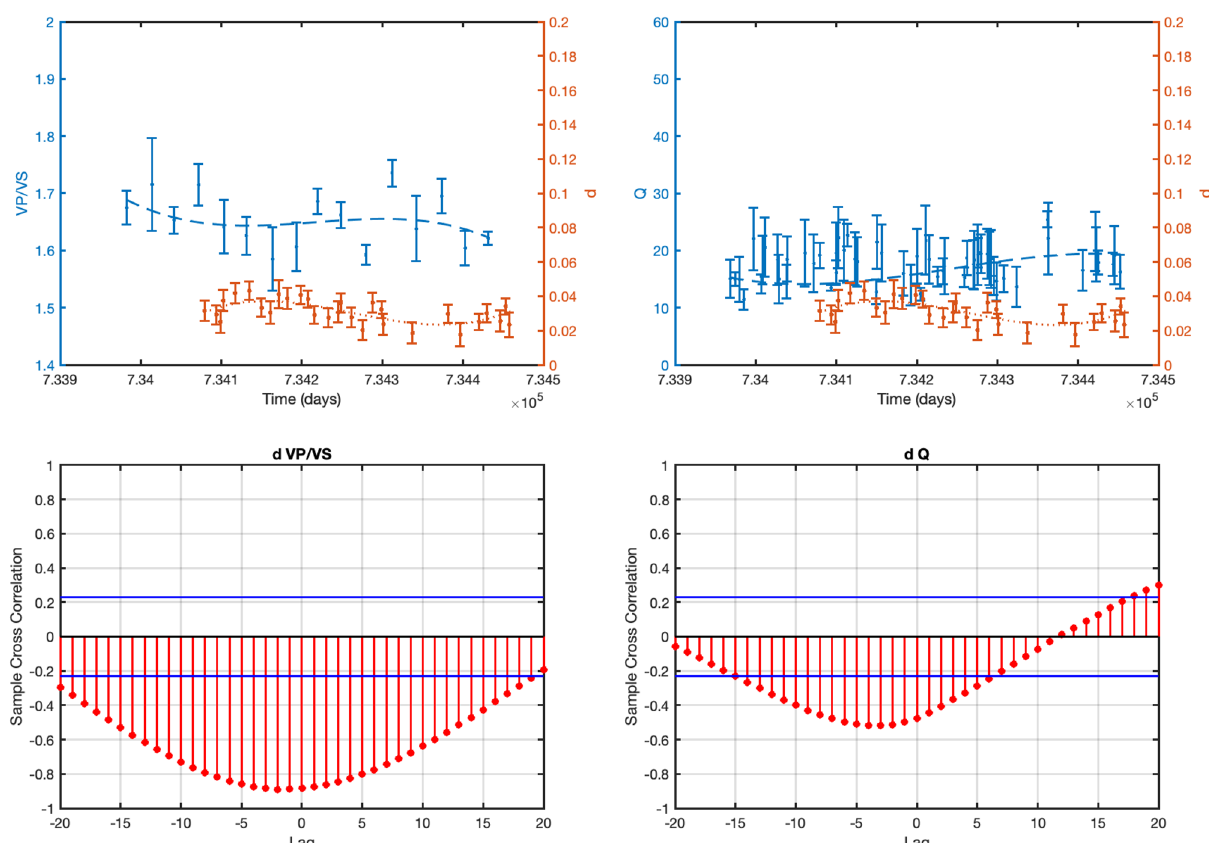
Figure 6. Cross correlation analysis for The Geysers geothermal field. The upper panels depict the data and the weighted polynomial fit for d (in absolute value), V P /V S and Q S . The lower panels show the sample cross-correlation results for d and V P /V S (left panel) and d and Q S (right panel) for different time-lags (time- lag = 5 days). The horizontal lines represent the 2-sigma confidence